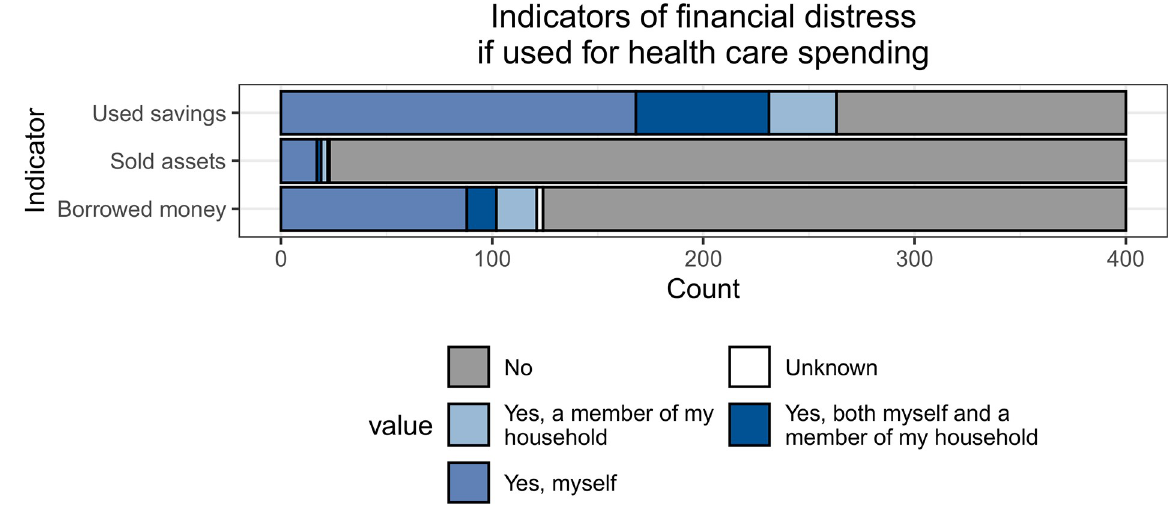
Fig 4. Indicators of financial distress if used for health care spending (n =